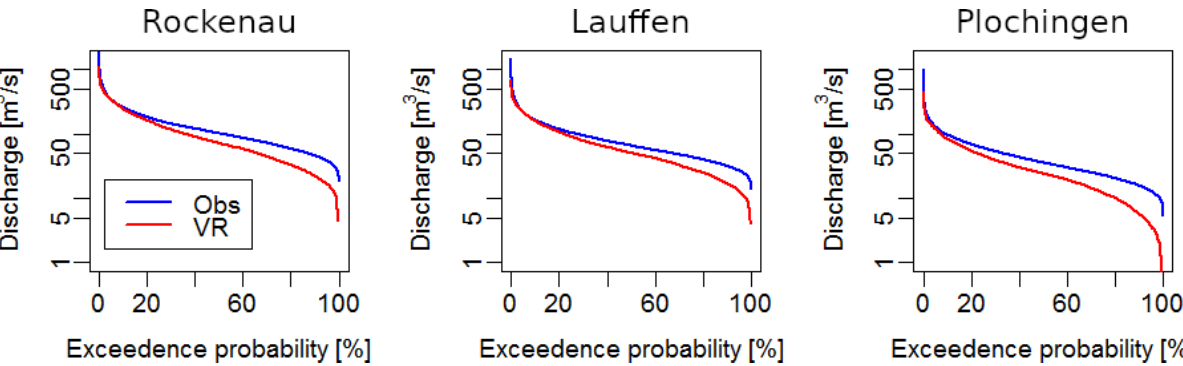
Figure A4. Flow duration curve for the three stations for the 3-year time period is based on. Blue: observations; red: simulated catchment.